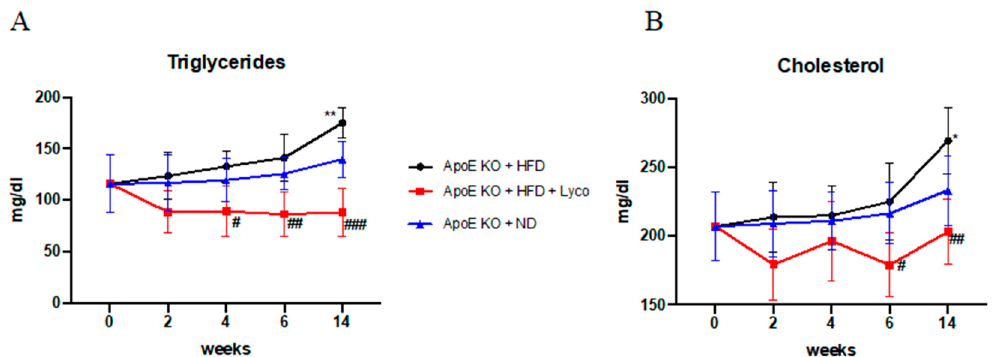
Figure 1. Triglyceride and cholesterol levels in blood evaluated during the experimental period. Values were obtained from 10 animals per group and are expressed as mean ± SD. Triglycerides ( A ) ** p < 0.001 vs. ApoE KO + ND; # p < 0.05 vs. ApoE KO + HFD; ## p < 0.001 vs. ApoE KO + HFD; ### p < 0.0001 vs. ApoE KO + HFD. Cholesterol ( B ) * p < 0.05 vs. ApoE KO + ND; # p < 0.05 vs. ApoE KO + HFD; ## p < 0.001 vs. ApoE KO + HFD.